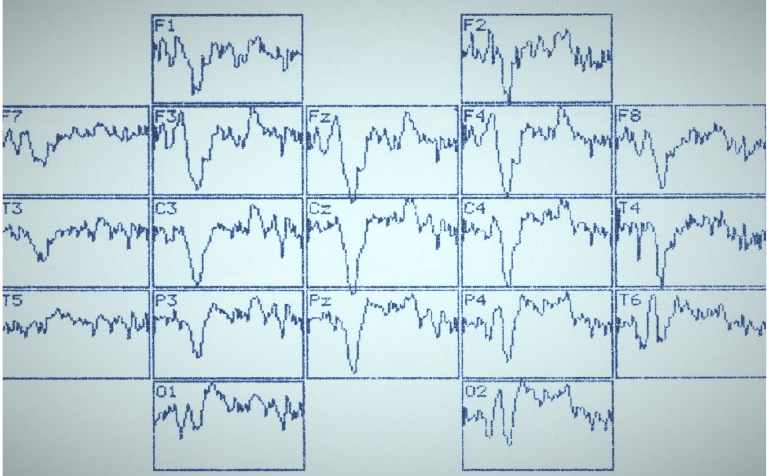
Figure 3. VEP distribution by the 10/20 system with correct recognition of one of the images-illusions. Analysis epoch: 1000 ms.